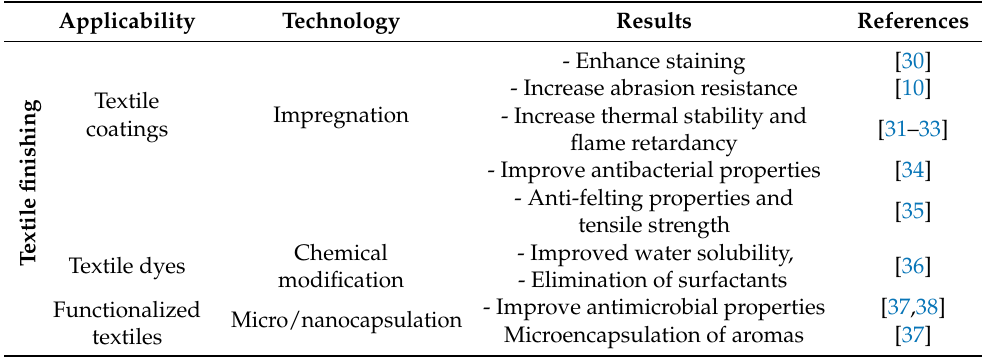
Table 3. Application of protein derived from the dairy by-products to the textile